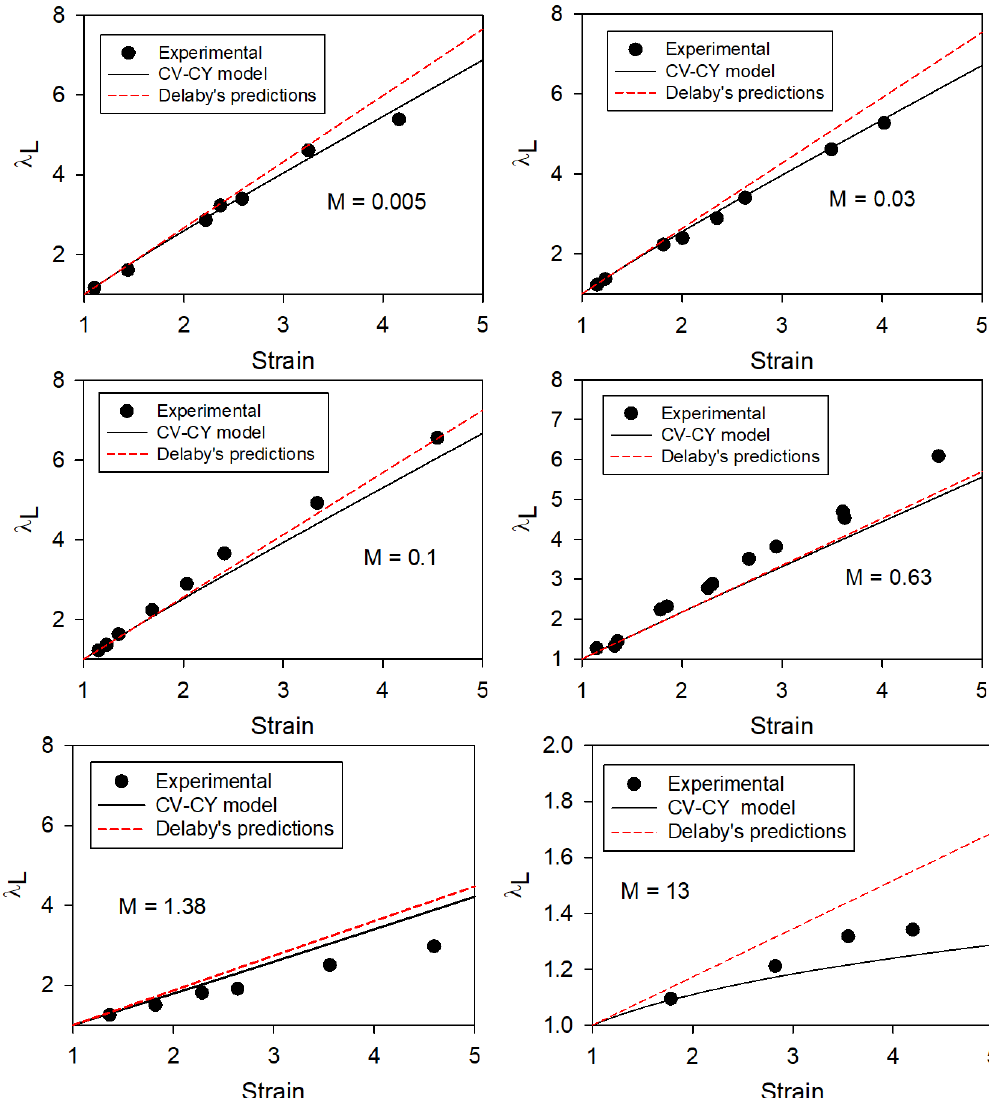
Figure 5: Stretching ratio ( λ L ) versus applied strain during extensional flow. The experimental data are from Delaby et al. [21]. The figure compares the CV-CY model (solid lines) to the experimental data point as well as to predictions of Delaby et al. [21] (dashed lines). The corrected viscosity ratio value is displayed in each sub-figure. The blends are arranged from small to large viscosity ratio values, with blend components (major phase – minor phase) as follows: PS1-PE2, PS2-PE2, PS1-PE1, PS2-PE1, PS1-PMMA and PS2-PMMA. The viscosity of each component is obtained according to the Carreau-Yasuda parameters provided in Table 2. Table 2: Values of the Carreau-Yasuda model for the polymers used in the Delaby et al. study [21]. Parameter PS1 PS2 PE1 PE2 PMMA (Pa · η o